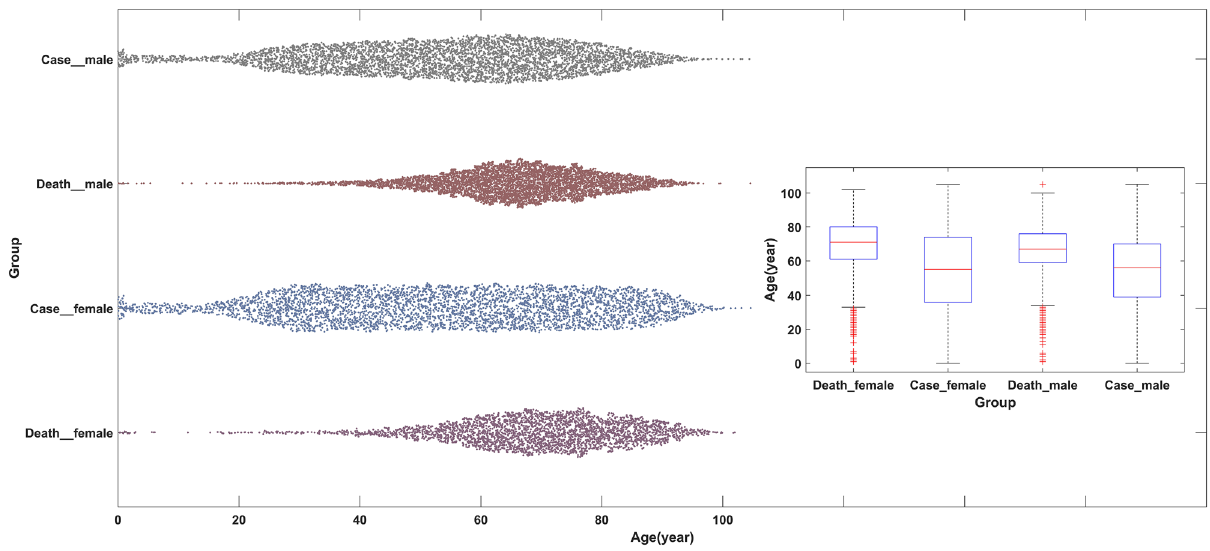
Figure 2. General characteristics and quality of COVID-19 cases. The scatter diagrams from the top to bottom were male cases who were infected with SARS-CoV-2 and hospitalized, male cases who were hospitalized and died, female cases who were infected with SARS-CoV-2 and hospitalized, and female cases who were hospitalized and died. The box plots from left to right corresponded to the scatter diagrams from the top to